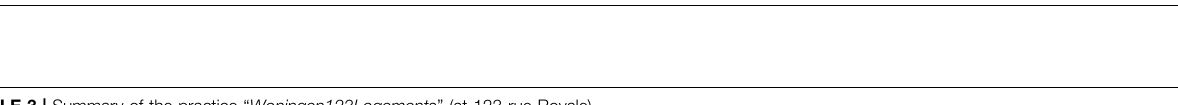
FIGURE 5 | Location in the BCR, aerial views from Google Maps of the location and photos from the website of 123 rue Royale consulted in September 2021.